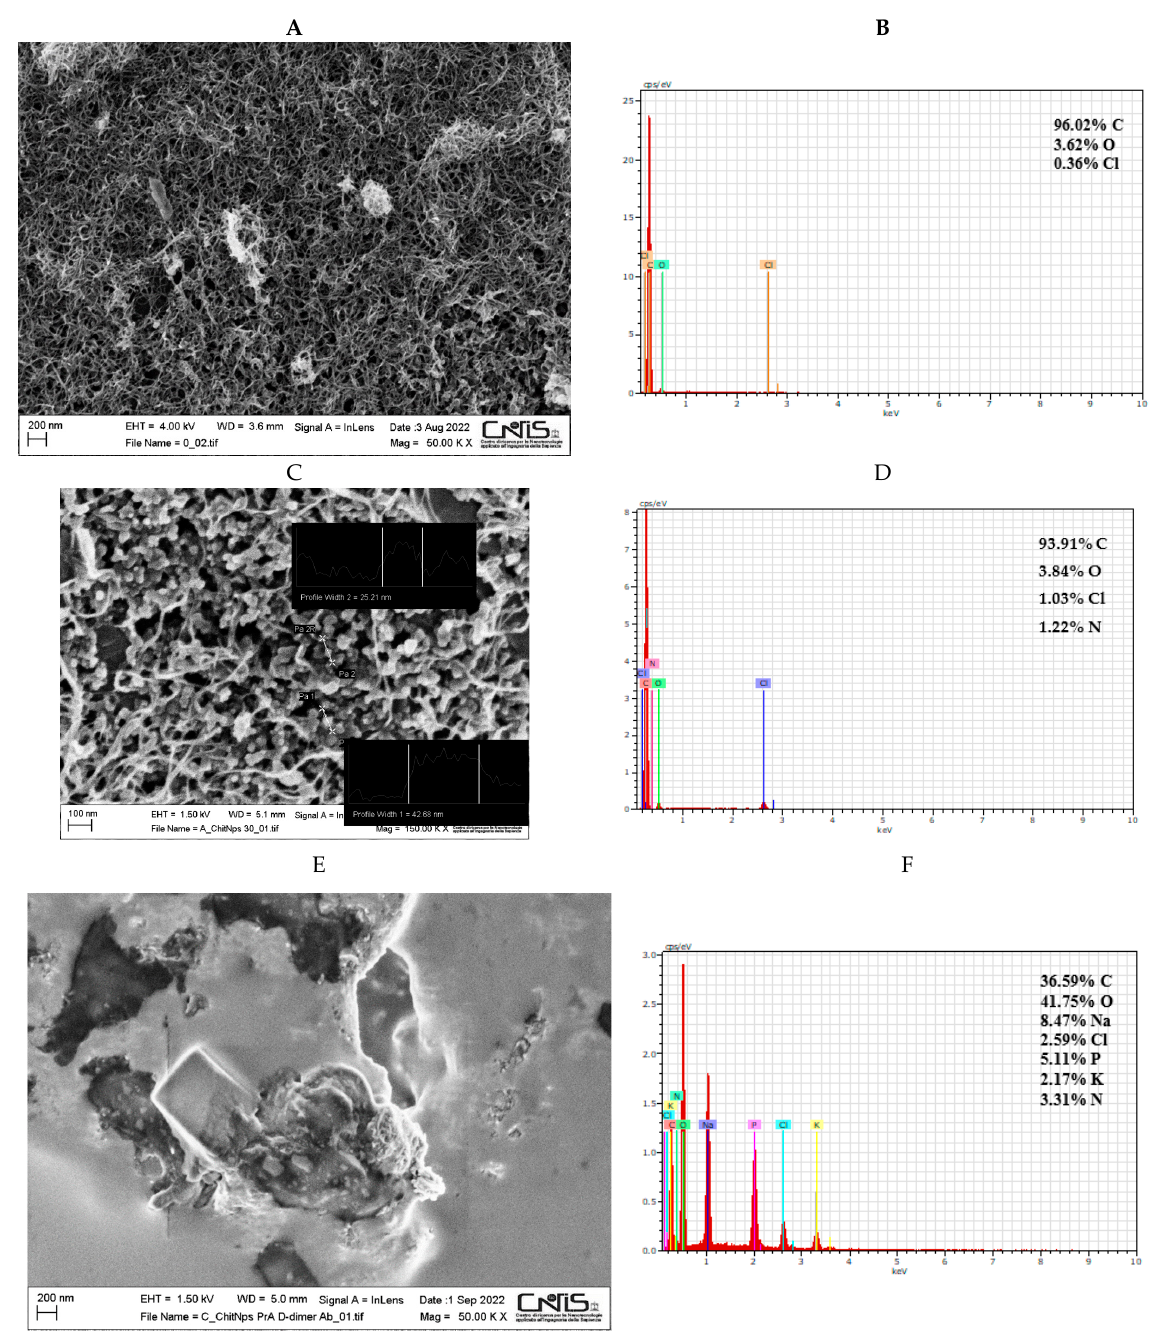
Figure 1. SEM images and EDX spectra for MWCNTs ( A , B ), MWCNTs-CSNPs ( C , D ), and MWCNTs-CSNPs-PrA-D-dimer Ab ( E , F ) SPEs. Experimental conditions: magnifications 50,000X ( A , E ) and 150,000X ( C ); voltage 1.50 kV.